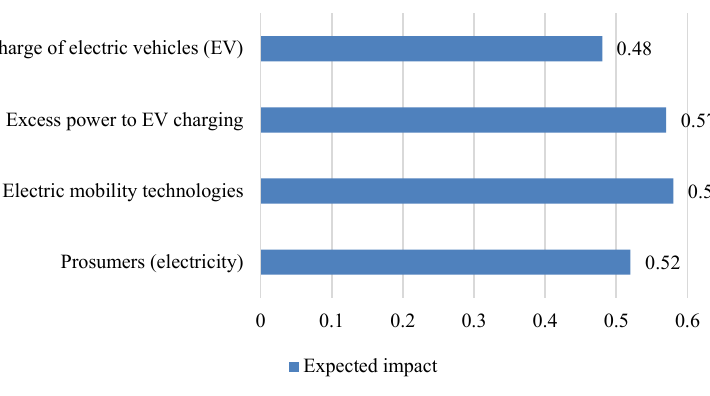
Fig. 4. Expected Impact on scale 0–1 of business models with highest score of